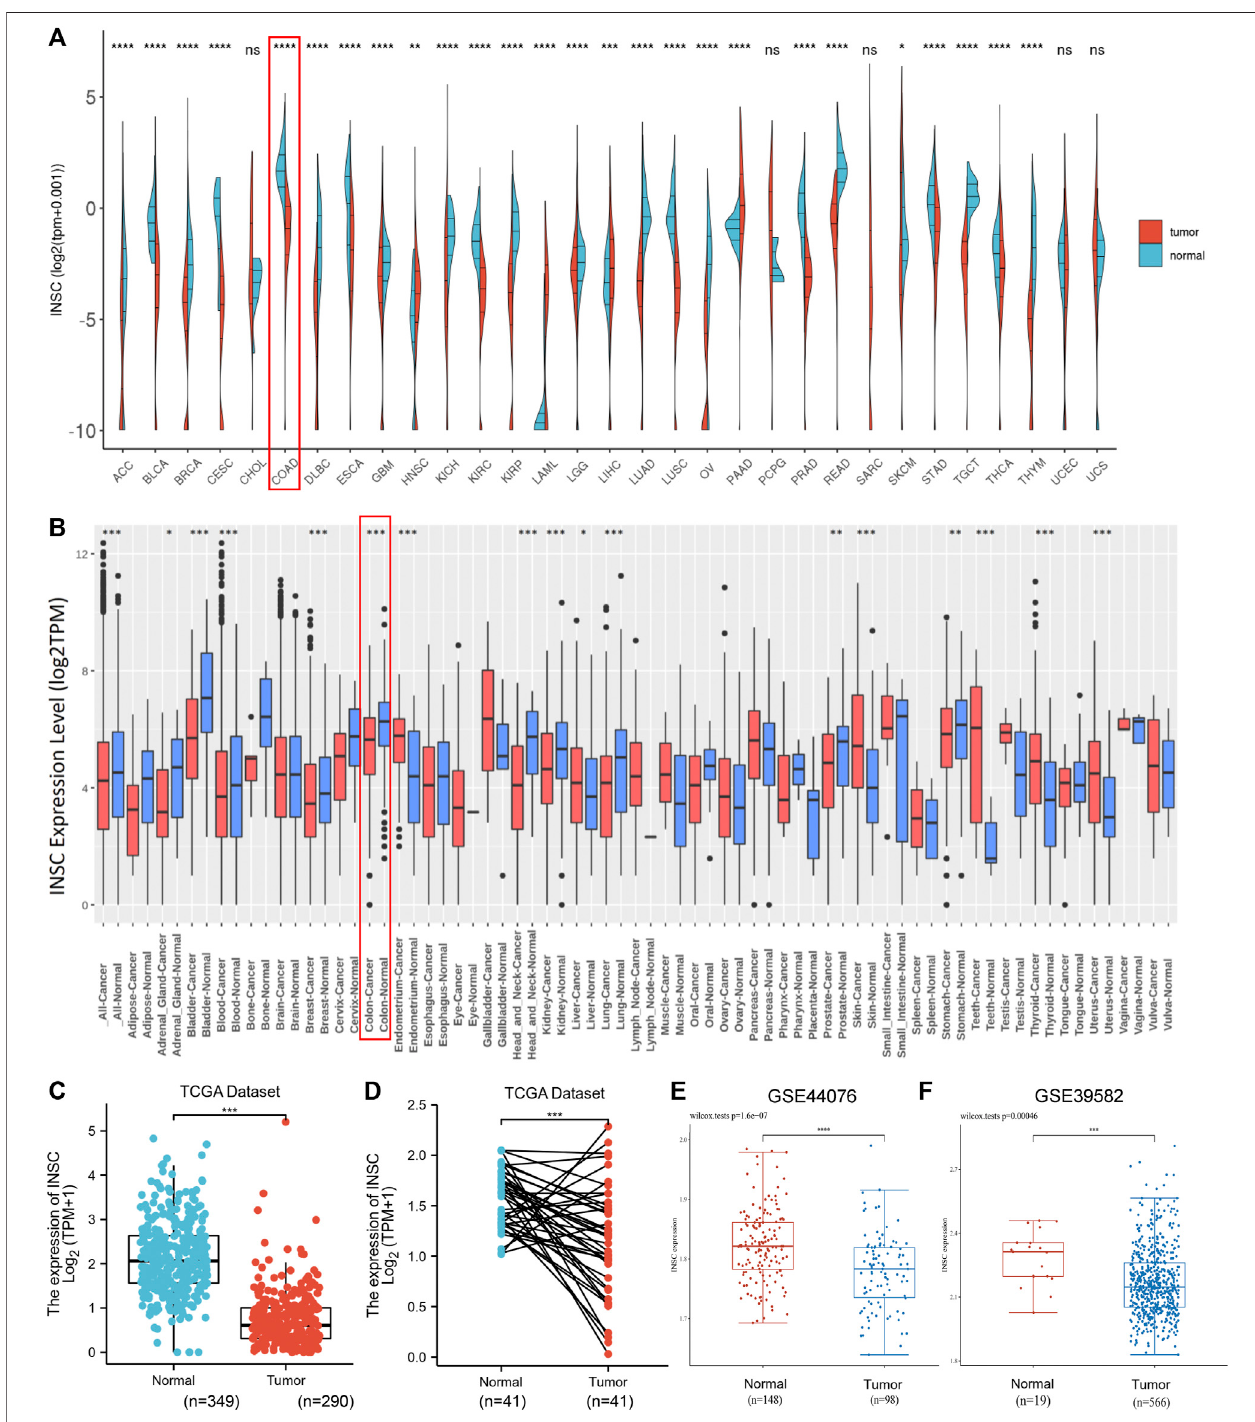
FIGURE 1 | INSC expression levels in cancers. (A – B) The expression levels of INSC were different in pan-cancer tissues compared to those in normal tissues according to TCGA datasets (A) and GEO datasets (B) , respectively. (C – D) Compared to the normal colon tissue, the expression level of INSC was signi fi cantly decreasedinCOADtissues( p < 0.001). (C) UnpairedsamplesinTCGAdatasetsandGTExdatasets. (D) PairedsamplesinonlyTCGAdatasets.TheexpressionofINSC from GSE44076 (E) and GSE39582 (F) in GEO datasets (* p < 0.05, ** p < 0.01, *** p < 0.001, **** p < 0.0001).